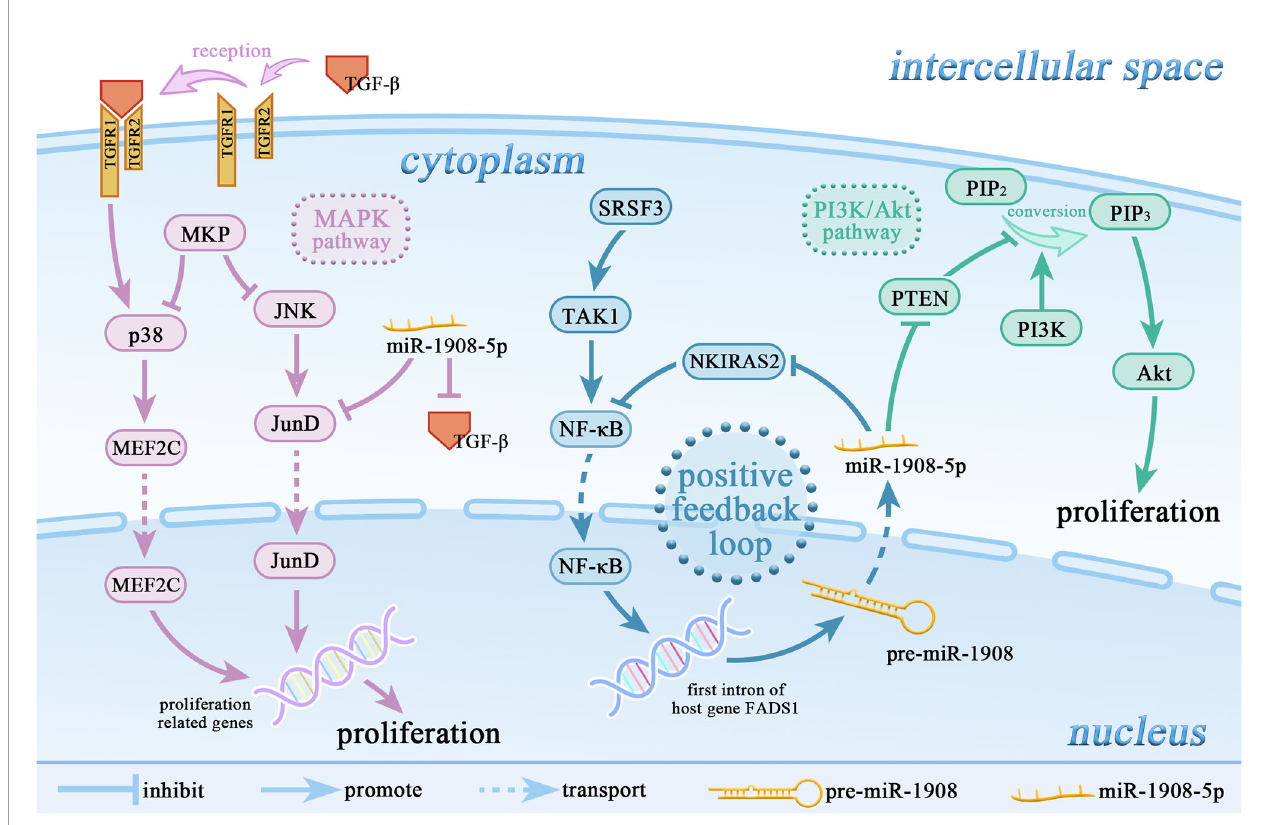
FIGURE 2 | miR-1908-5p is involved in the regulation of multiple signaling pathways. miR-1908-5p plays an important role in the MAPK signaling pathway and PI3k/ Akt signaling pathway. The positive feedback loop of NF- k B/miR-1908-5p/NKIRAS2/NF- k B enhances the promoting effect of the SRSF3/TAK1/NF- k B axis on the expression of